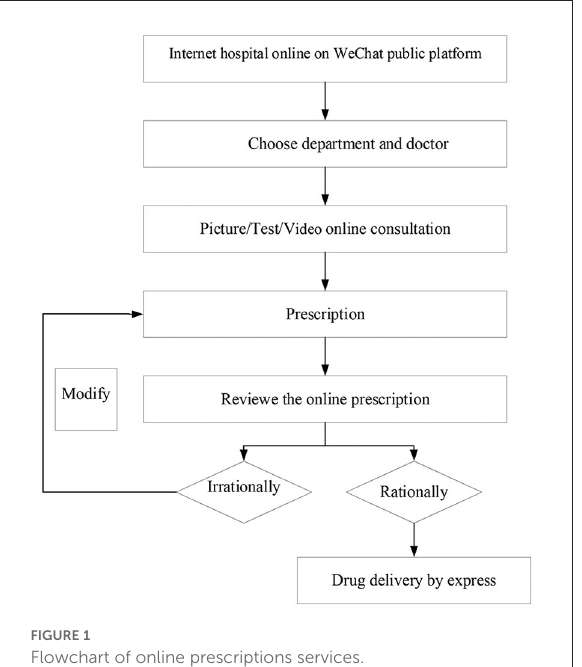
FIGURE1 Flowchart of online prescriptions services.